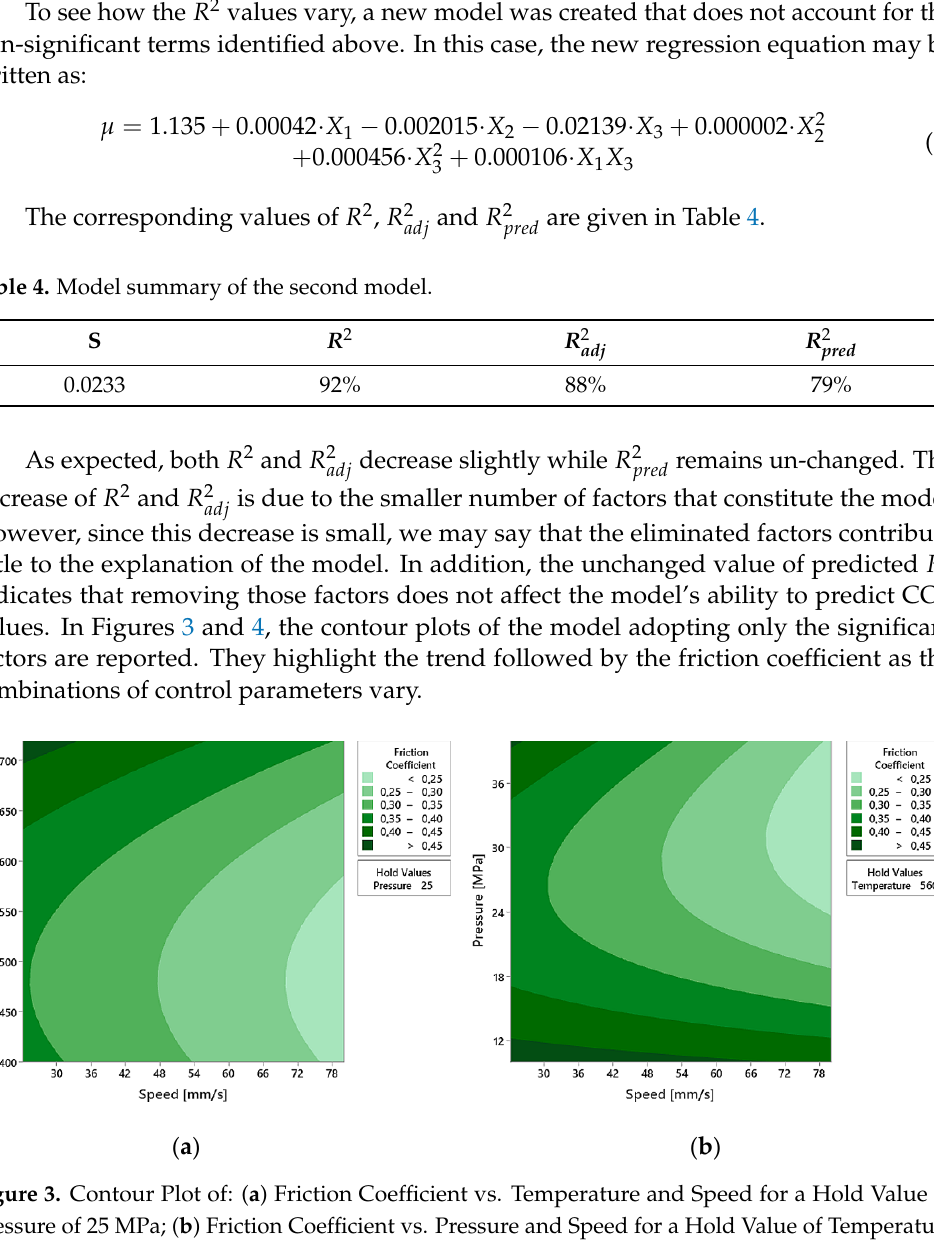
Figure 4. Contour Plot of Friction Coefficient vs. Temperature and Pressure for a Hold Value of Speed of 45 mm/s. Figure 3a shows how, for a fixed pressure value (25 MPa), the friction coefficient in- creases as temperature increases and speed decreases; this trend is similar to that obtained by Yanagida [1]. In Figure 3b, for a fixed temperature value of 560 °C, the COF increases as speed decreases and assumes an unusual behavior as pressure varies. In Figure 4, for a value of velocity equal to 45 mm/s, the COF decreases when the temperature varies be- tween 400 °C and 500 °C and increases to over 500 °C. This trend can be explained by the fact that for high-temperature values, adhesion phenomena occur between the jaws and the strip, leading to an increase in tensile force and, consequently, in the COF. Instead, regarding the pressure effects, the trend is uncertain, and further studies are required to understand better the correlation between this parameter and the response variable. The observed trends are new compared with those that emerged from the state-of-the-art anal- ysis. FEA Results The numerical results are reported for one arbitrarily chosen combination of param- eters. In particular, the combination of parameters chosen is the following: •